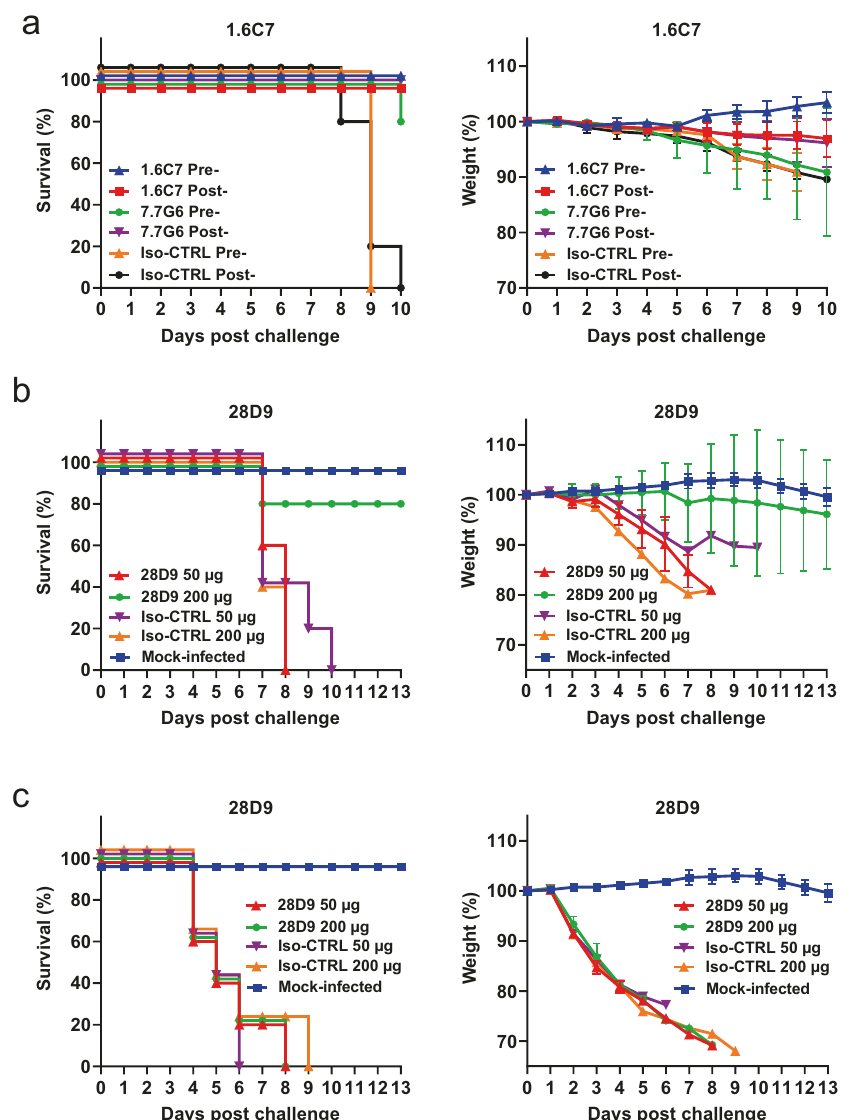
Fig. 7 Antibody-mediated protection of mice against lethal MERS-CoV/SARS-CoV challenge. a The in vivo prophylactic and therapeutic activity of the 1.6C7 mAb against lethal dose MERS-CoV challenge was tested in the K18 transgenic mouse model expressing human DPP4 53 . A potent neutralizing MERS-S1 antibody (7.7G6) or an irrelevant IgG1 control antibody was taken along. Eight 20 – 30-week-old mice were injected with 50 μ g of antibody (equivalent to 1.8 mg mAb/kg body weight) by intraperitoneal injection 24 h before (pre-) or 24 h after (post-) intranasal infection with a lethal dose of MERS-CoV. Survival rates (left) and weight loss (right, expressed as a percentage of the initial weight) were monitored daily until 10 days post-inoculation. Data points represent mean body weight relative to the initial weight ± SD, n = 8 mice. Source data are provided as a Source Data fi le. b Prophylactic ef fi cacy of 28D9 against MERS-CoV infection. Five 20-week-old K18 mice were mock-infected or injected with 50 or 200 μ g of 28D9 (equivalent to 1.8/ 7.2 mg mAb/kg body weight) or isotype control antibody by intraperitoneal injection 24 h before intranasal infection with a lethal dose of MERS-CoV. Data points represent mean body weight relative to the initial weight ± SD, n = 5 mice. Source data are provided as a Source Data fi le. c Prophylactic ef fi cacy of 28D9 against SARS-CoV infection. Five 16-week-old Balb-C mice were mock-infected or administered with the 50 or 200 μ g of 28D9 or isotype control antibody via intraperitoneal injection 24 h before intranasal infection with a lethal dose of mouse-adapted SARS-CoV. Survival rates (left) and weight loss (right, expressed as a percentage of the initial weight) were monitored daily until 13 days post-inoculation. Data points represent mean body weight relative to the initial weight± SD, n = 5 mice. Source data are provided as a Source Data fi